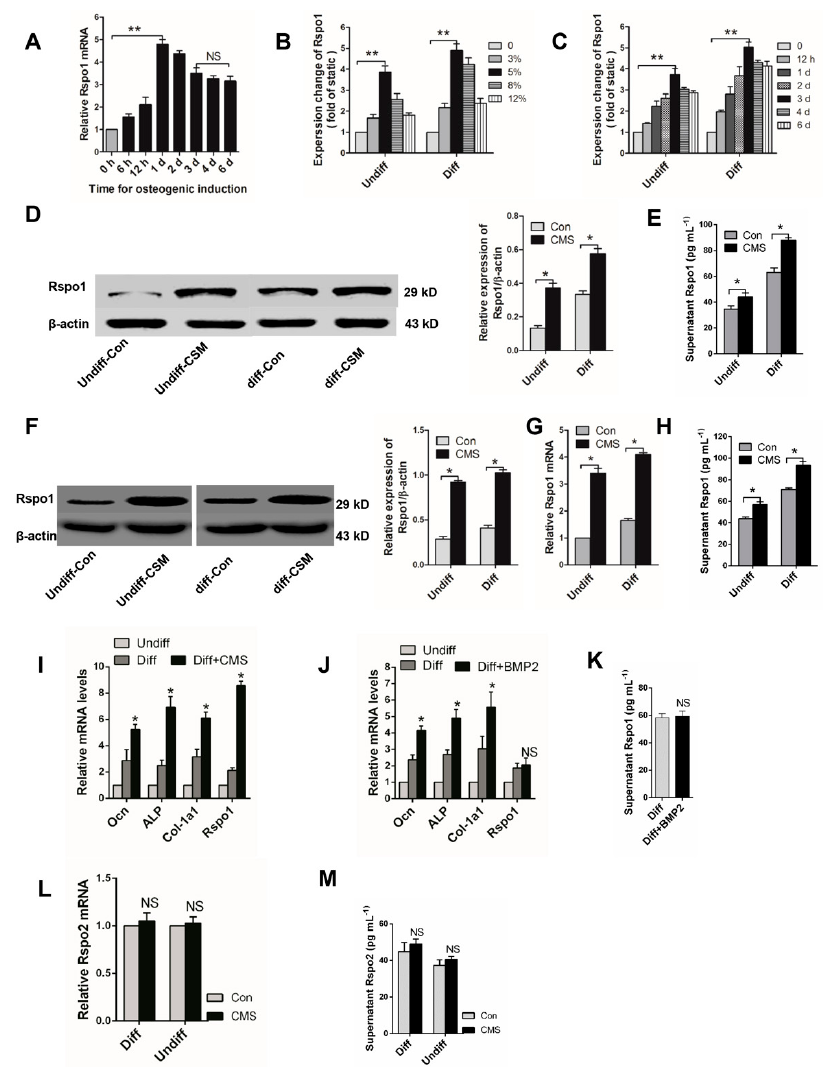
(Figure 1F), mRNA level (Figure 1G) and supernatant level (Figure 1H) of Rspo1 were all significantly upregulated in MC3T3-E1 cells when treated with 5% CMS for three days. Int. J. Mol. Sci. 2017 , 18 , 564